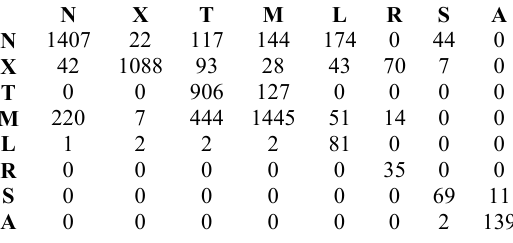
Table 4. Comparison of Gaussian and Supervised Discretization Naïve Bayes with dataset 5